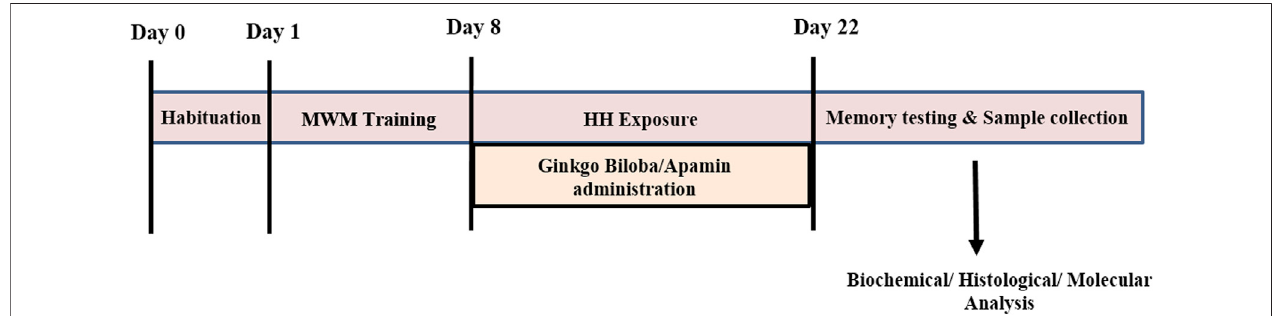
FIGURE1| Timelinediagramshowingtheexperimentaldesignofthestudy.Day0representshabituationoftheratsintheMWMtankfollowedby8 daysoftraining. At day 8, rats were exposed to HH at 25,000 ft for 14 days along with GBE and apamin treatment. After completion of exposure, memory testing and sample collection were performed for further